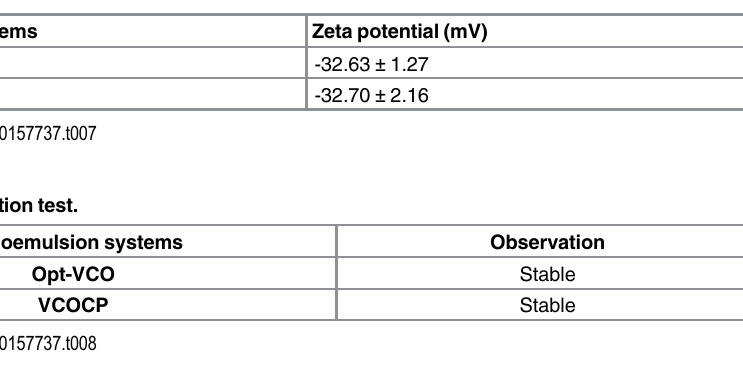
Table 7. Zeta potential (mV) of the optimum VCO nanoemulsion and VCO nanoemulsion containing active compound.